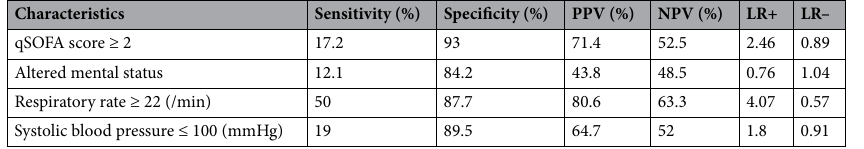
Table 2. Diagnostic predictive values of each criterion regarding qSOFA score for bacteremia. PPV, positive predictive value; NPV, negative predictive value; LR, likelihood ratio.